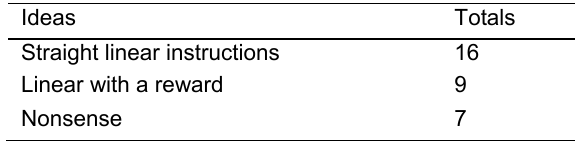
Table 3. Number of unique ideas and the